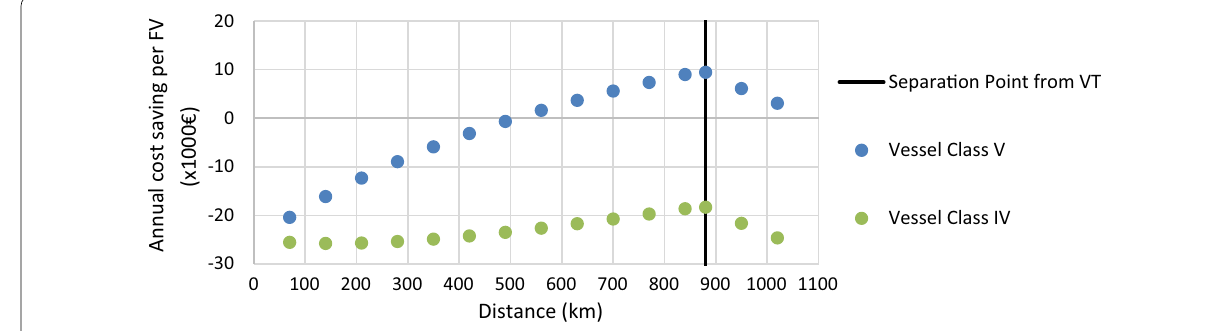
Fig. 5 Annual cost savings per FV for the Danube vessel class IV and V